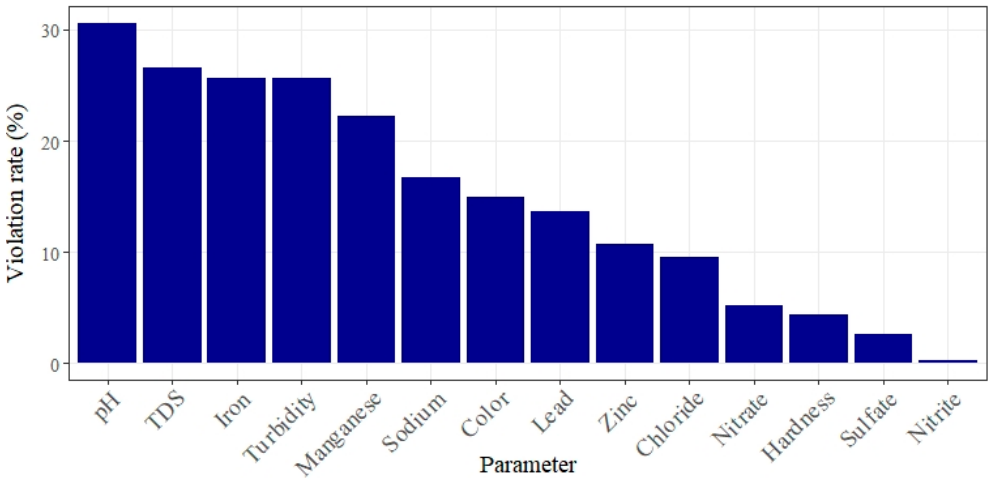
Figure 8. Violation rates of the groundwater quality standards in Jakarta.